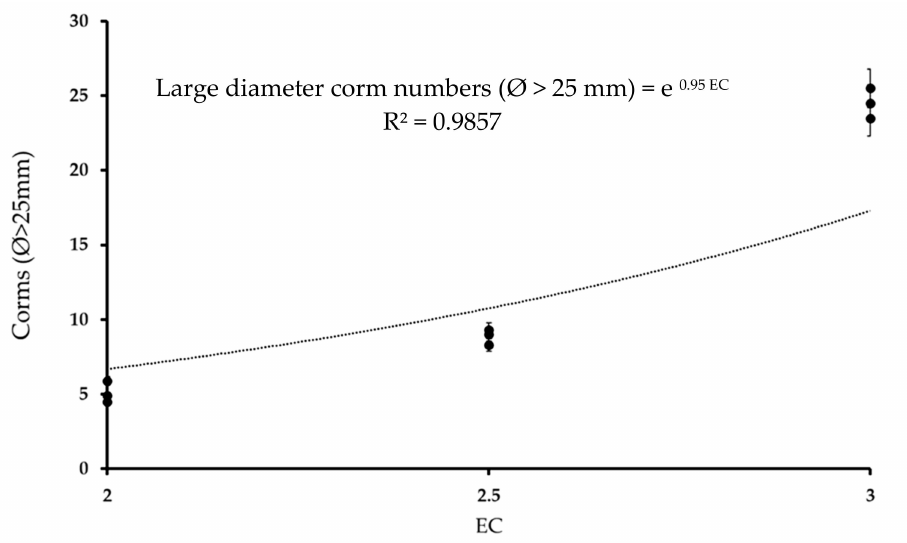
Figure 1. Regression equation between EC nutrient solutions and large diameter corm numbers (Ø > 25 mm) of sa ff ron grown in perlite fertigated with nutrient solutions at three EC levels 2.0, 2.5 and 3.0 dS · m − 1 .